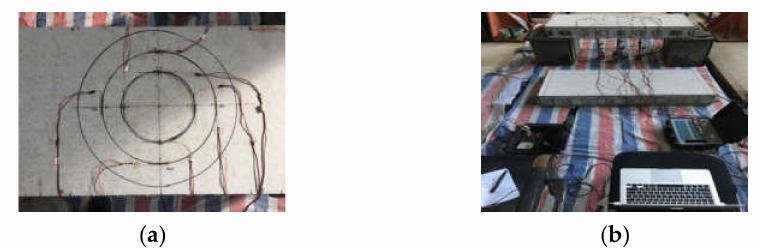
Figure 7. Test layout. ( a ) Wire layout; ( b ) Device